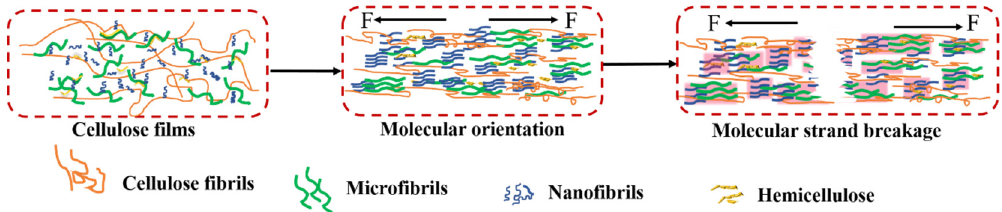
Figure 9. Schematic of tensile mechanism of